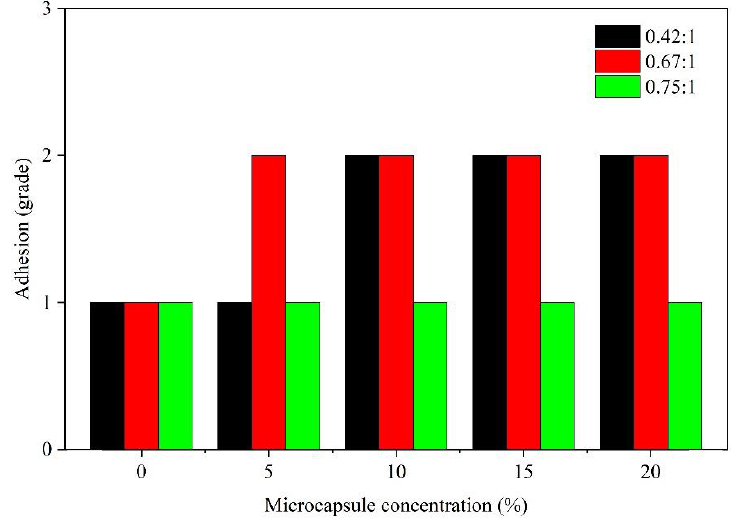
Figure 5. E ff ect of microcapsule concentration (0.42:1, 0.67:1, and 0.75:1 core-wall ratios) on adhesion.